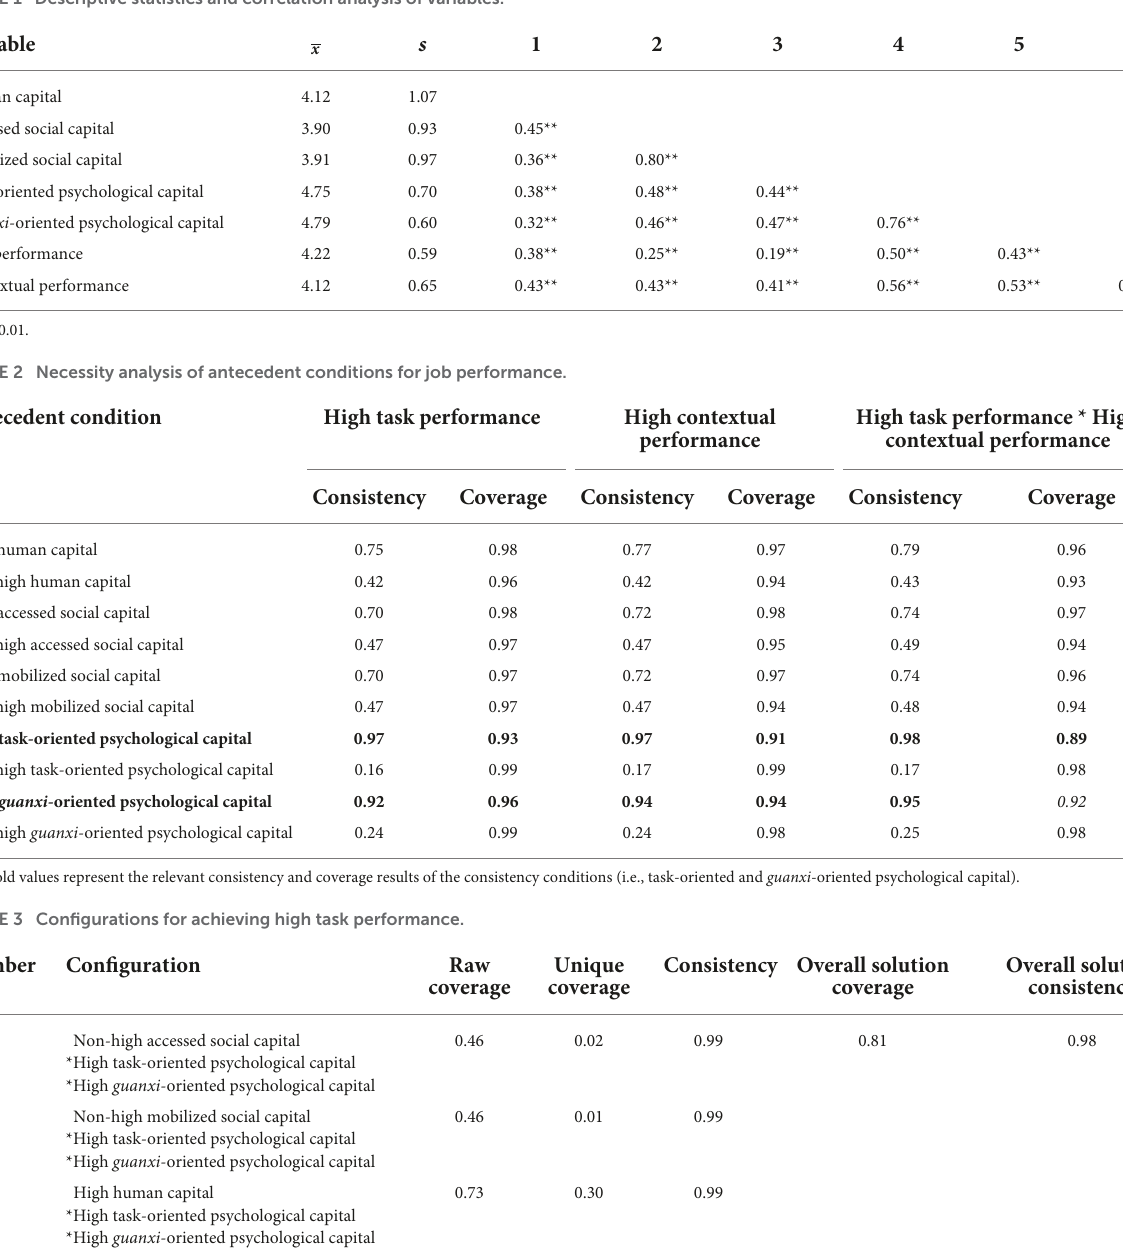
TABLE 1 Descriptive statistics and correlation analysis of variables.